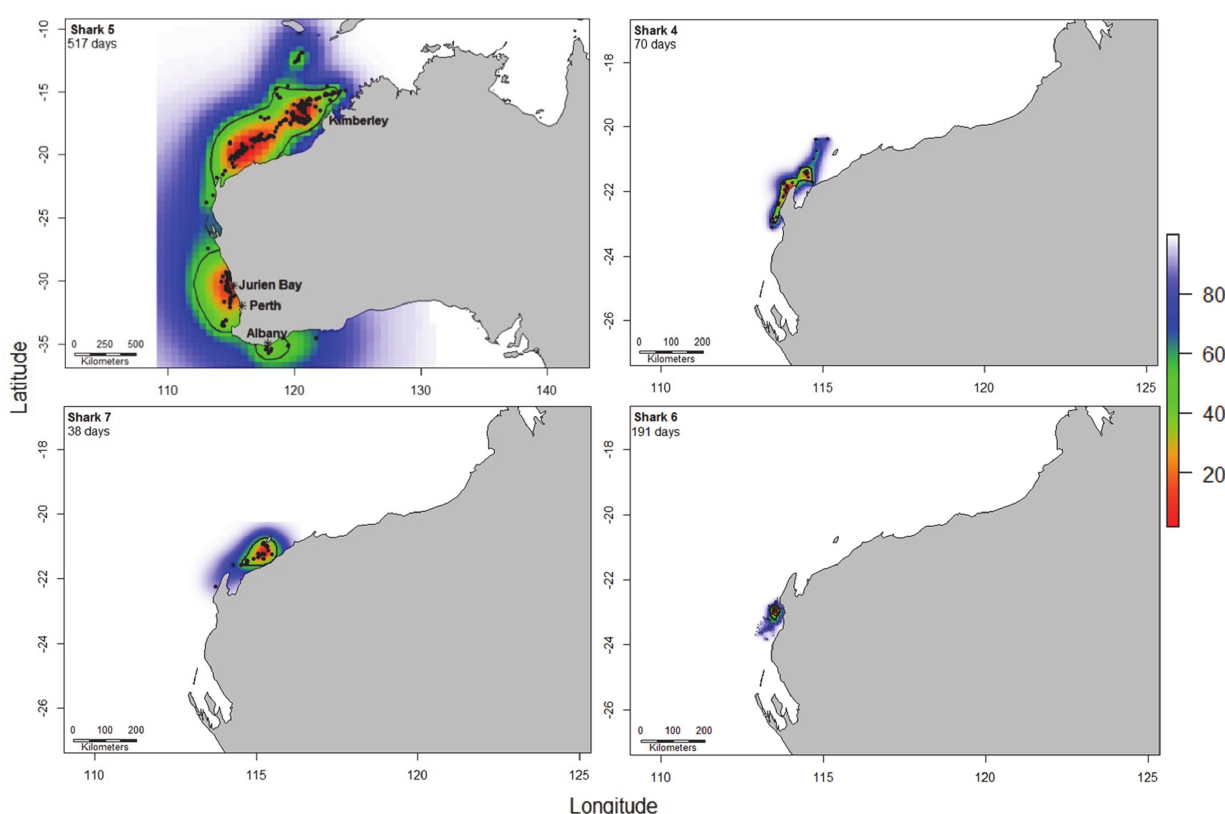
Fig 2. Home range of tiger sharks. The utilisation distribution calculated using the Brownian Bridge kernel method. Black line represents the 50% Brownian Bridge home range distribution.